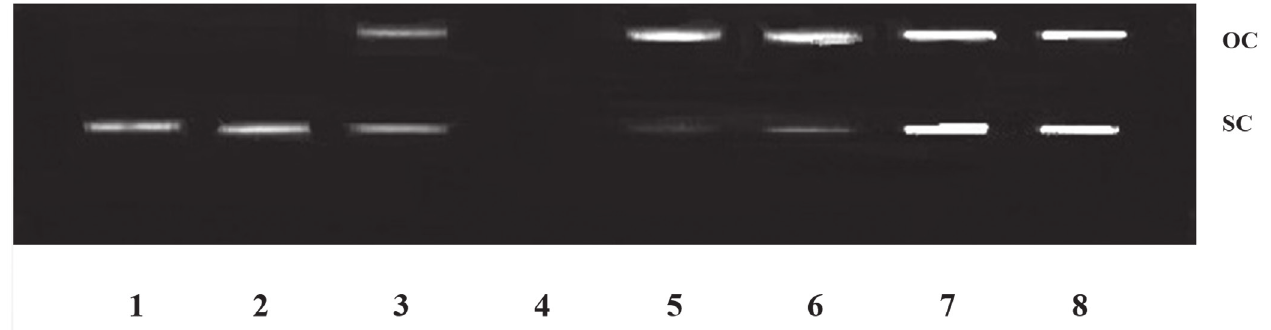
FIGURE 4 – Gel electrophoresis of pUC-19 DNA in the presence of Cu(II) and AA. Saturated air solution ([O